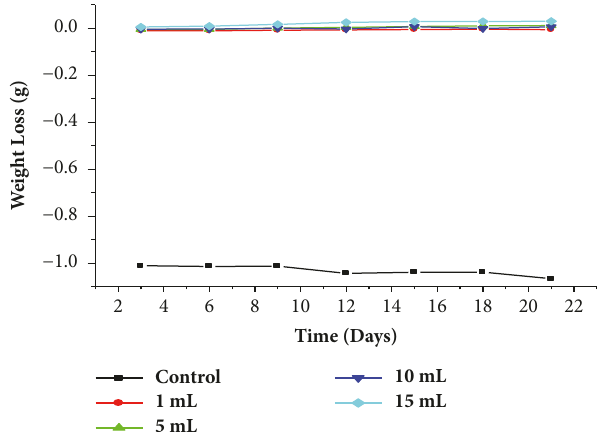
Figure 3: Variation of inhibition efficiency against time for the cathodic protection and different volumes of oil extracts for steel with zinc in seawater.